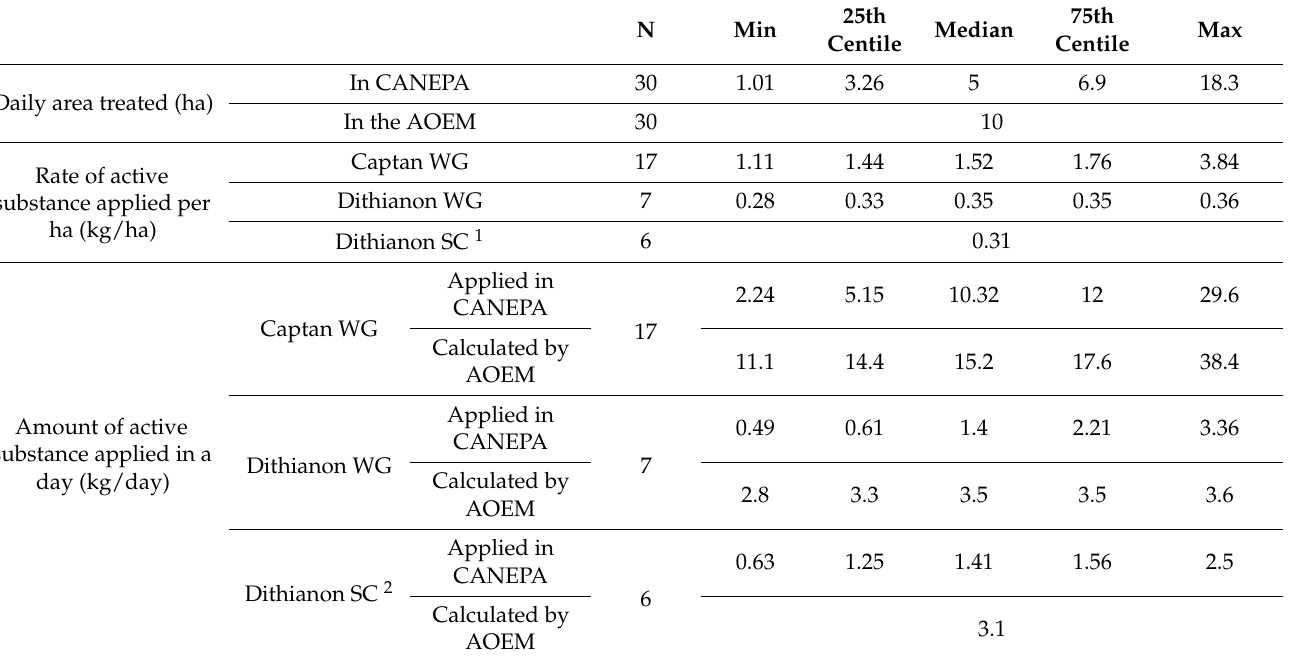
Table 1. Daily amount of active substance applied and daily treated